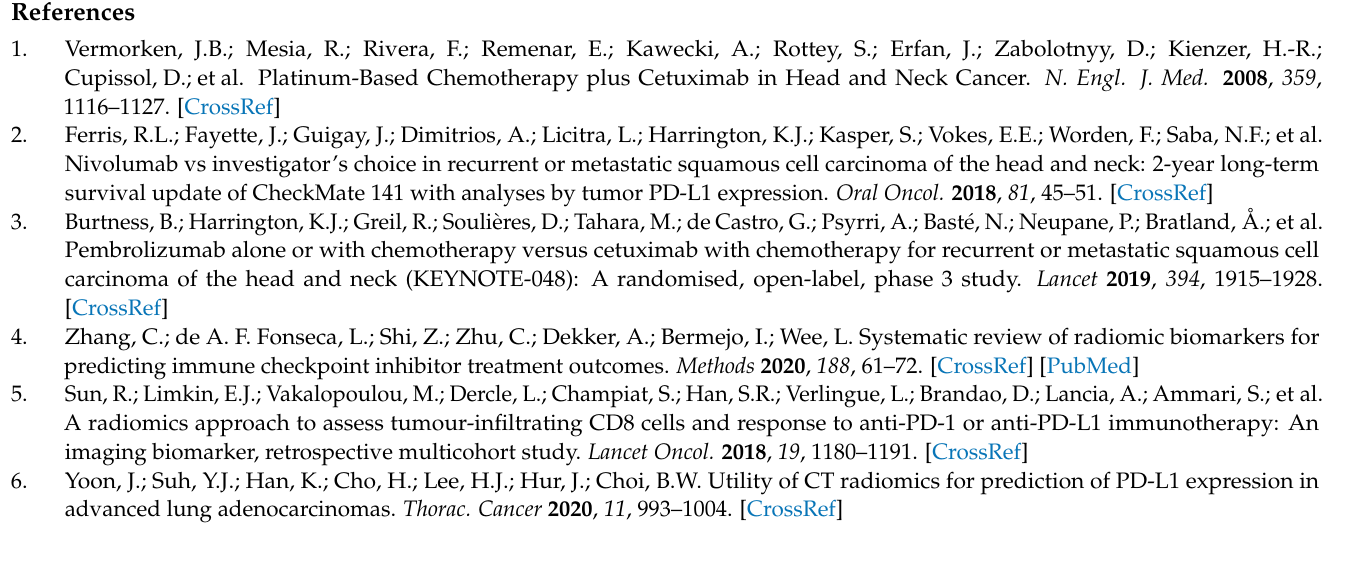
Table S2, Image acquisition parameters for the computed tomography (CT) images used in the studies. Numeric values are expressed as median and inter-quartile ranges. Figure S1, Example of computed tomography image with the segmented